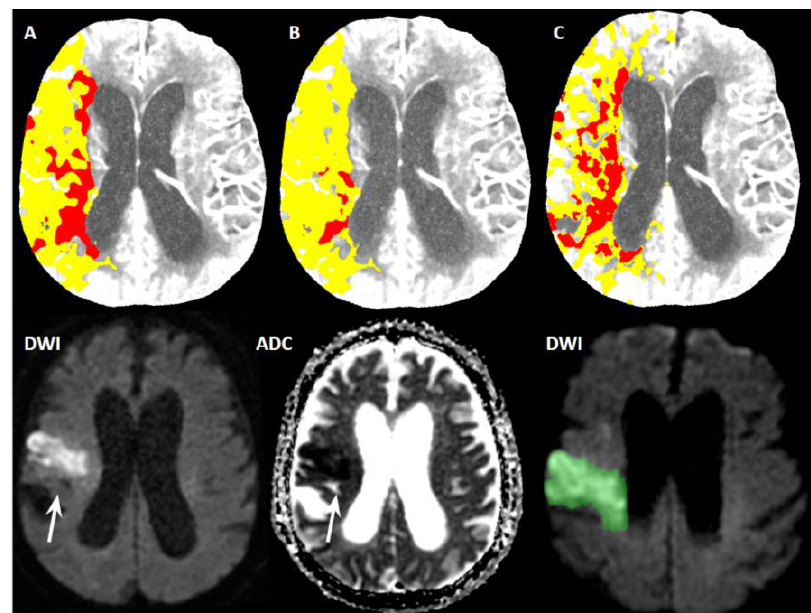
Figure 2. Bland – Altman plots comparing ischemic core volume on CT perfusion for each setting and the final infarct volume on magnetic resonance imaging follow-up. Shaded areas represent 95% confidence intervals for the upper/lower limit of agreement (green/red) and for bias (blue).